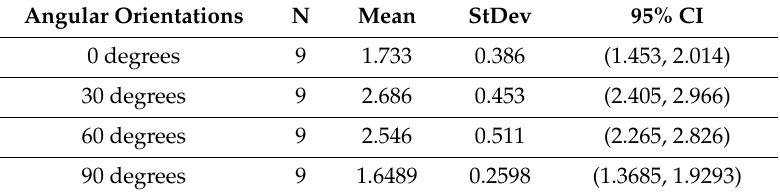
Table 31. Mean, standard deviation, confidence interval for Ra as a function of angular